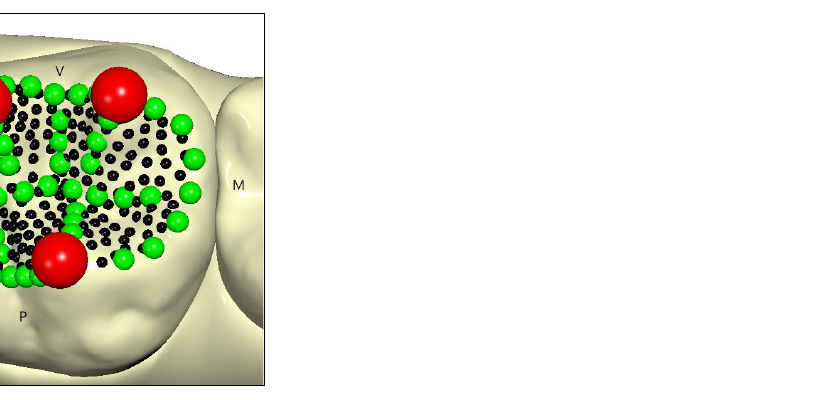
Figure 2. Distribution of landmarks (red points) and semilandmarks (green and black points) on the molar occlusal surface.